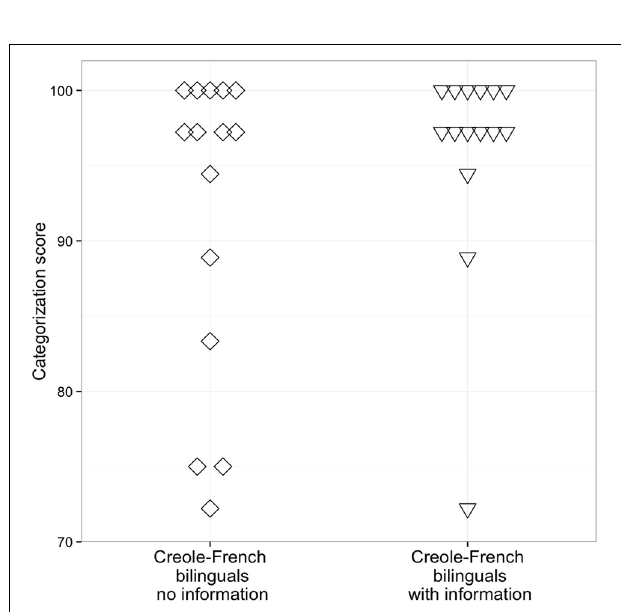
consonants can be modified by introducing small changes